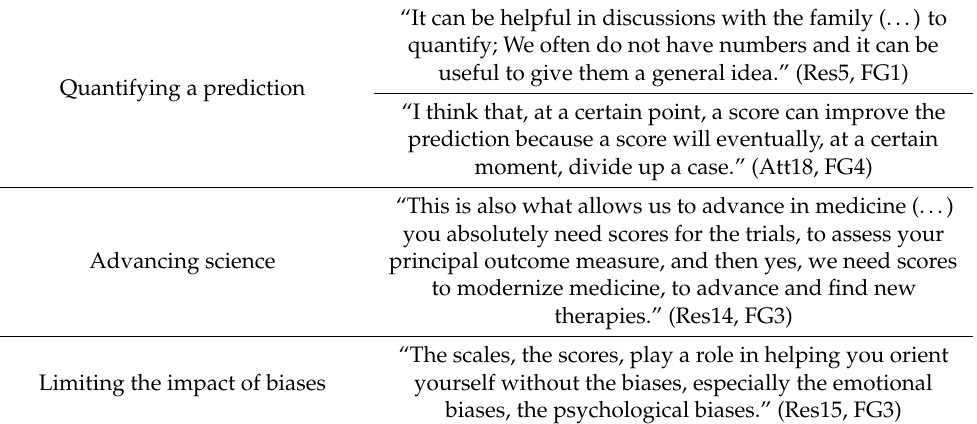
Table 2. Potential value of prognostic scores.